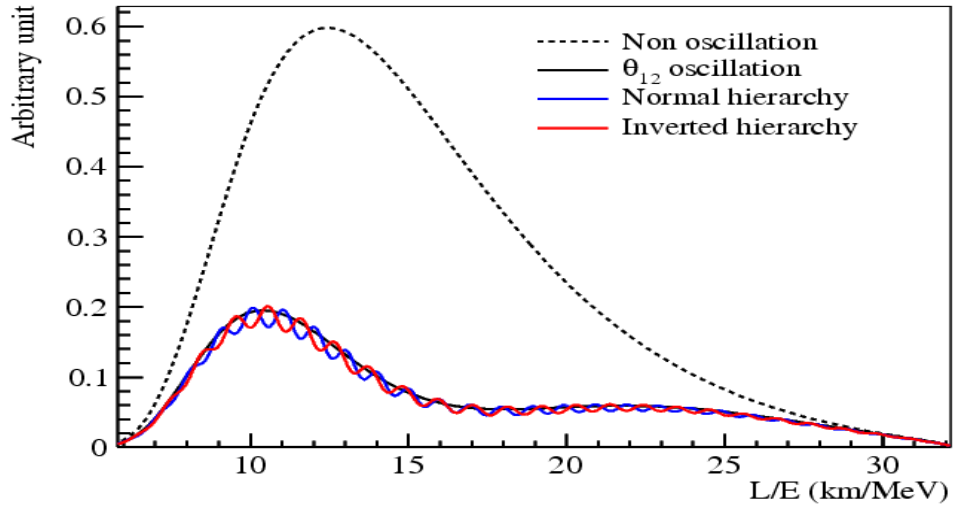
Figure 3. Expected reactor antineutrino spectrum, represented as a function of the ratio L correspond to the spectrum in absence of oscillation (dotted line), in presence of oscillation but for θ 13 = 0 (full black), and in the realistic case of oscillation for normal (blue line) or inverted (red curve) neutrino mass ordering. Figure taken by ([101]). Copyright 2008 by the American Physical Society.